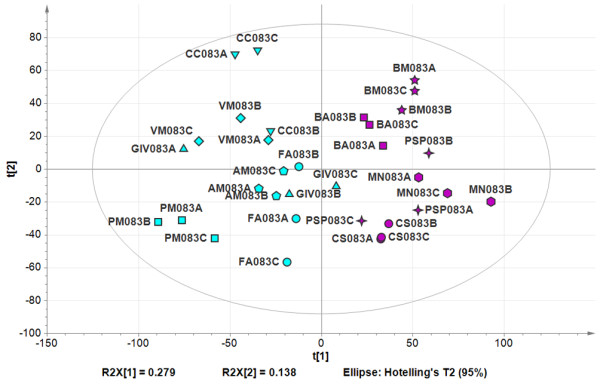
Grapevine transcripts showing plasticity at harvest. Principal component analysis of the whole third-stage dataset. The variables and scores scatter plot of the PCA model (nine components, R2X (cumulative) = 0.84, Q2 (cumulative) = 0.602) was generated using Simca P+ 13.0 and colored according to the disparity in the degree of ripening, as illustrated in Figure S7C (Additional File 15). Different vineyards are indicated by different symbols. Sample names are composed by vineyard abbreviation, followed by the indication of the harvesting year (08), by the indication of the developmental stage (3), and by the description of the biological replicate (A, B, or C).